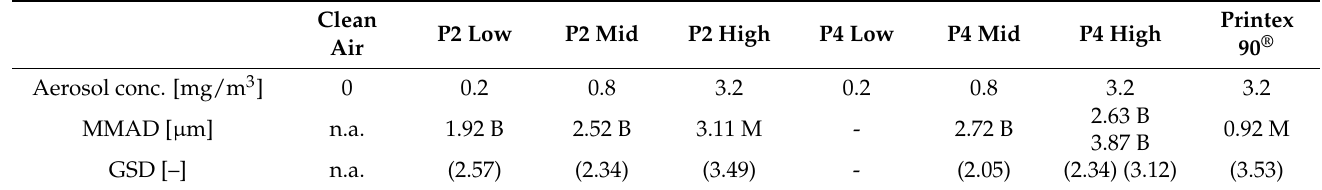
Table 2. Dosing scheme of the 28-day nose-only inhalation test with 28 days of recovery.